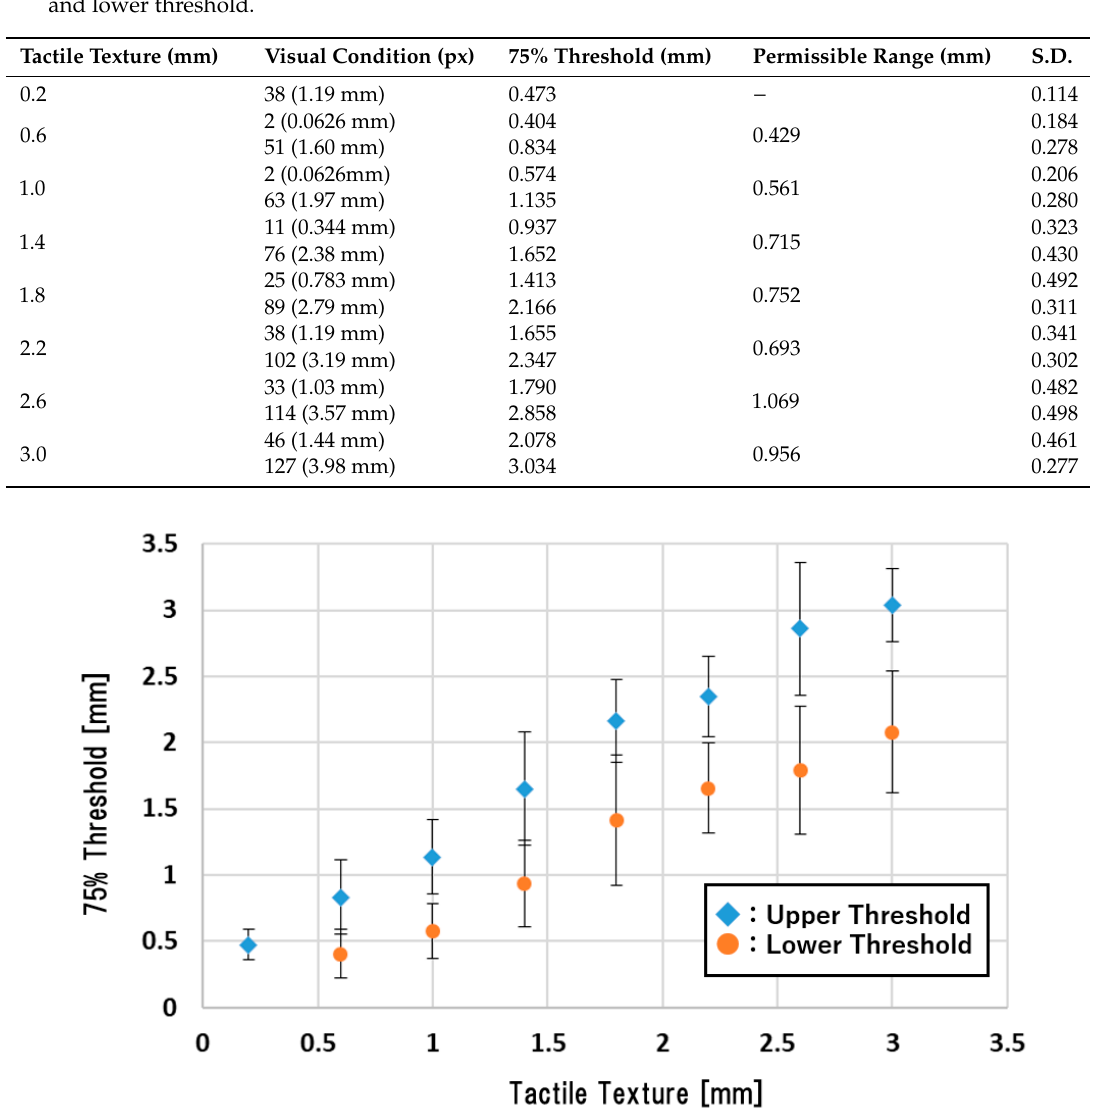
Figure 6. Plot of the results in Table 1. The horizontal and vertical axes represent the tactile spatial period and the threshold, respectively. Error bars represent the standard deviation.